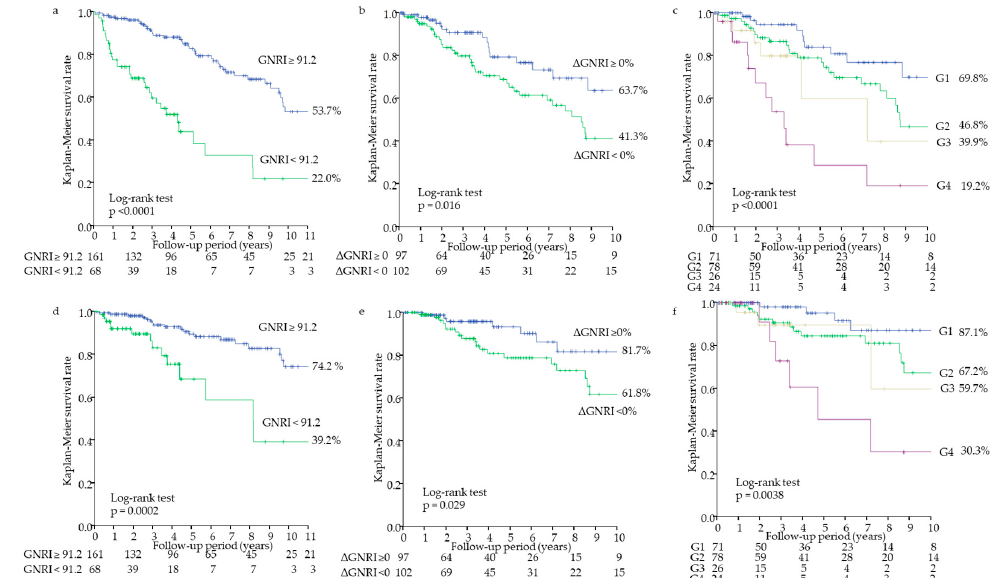
Figure 2. Kaplan–Meier survival curves for all-cause and cardiovascular mortality. All-cause mortality for GNRI < 91.2 vs. GNRI ≥ 91.2 ( a ), ∆ GNRI < 0% vs. ∆ GNRI ≥ 0% ( b ), and among the four groups divided by the GNRI and ∆ GNRI ( c ). Cardiovascular mortality for GNRI < 91.2 vs. GNRI ≥ 91.2 ( d ),